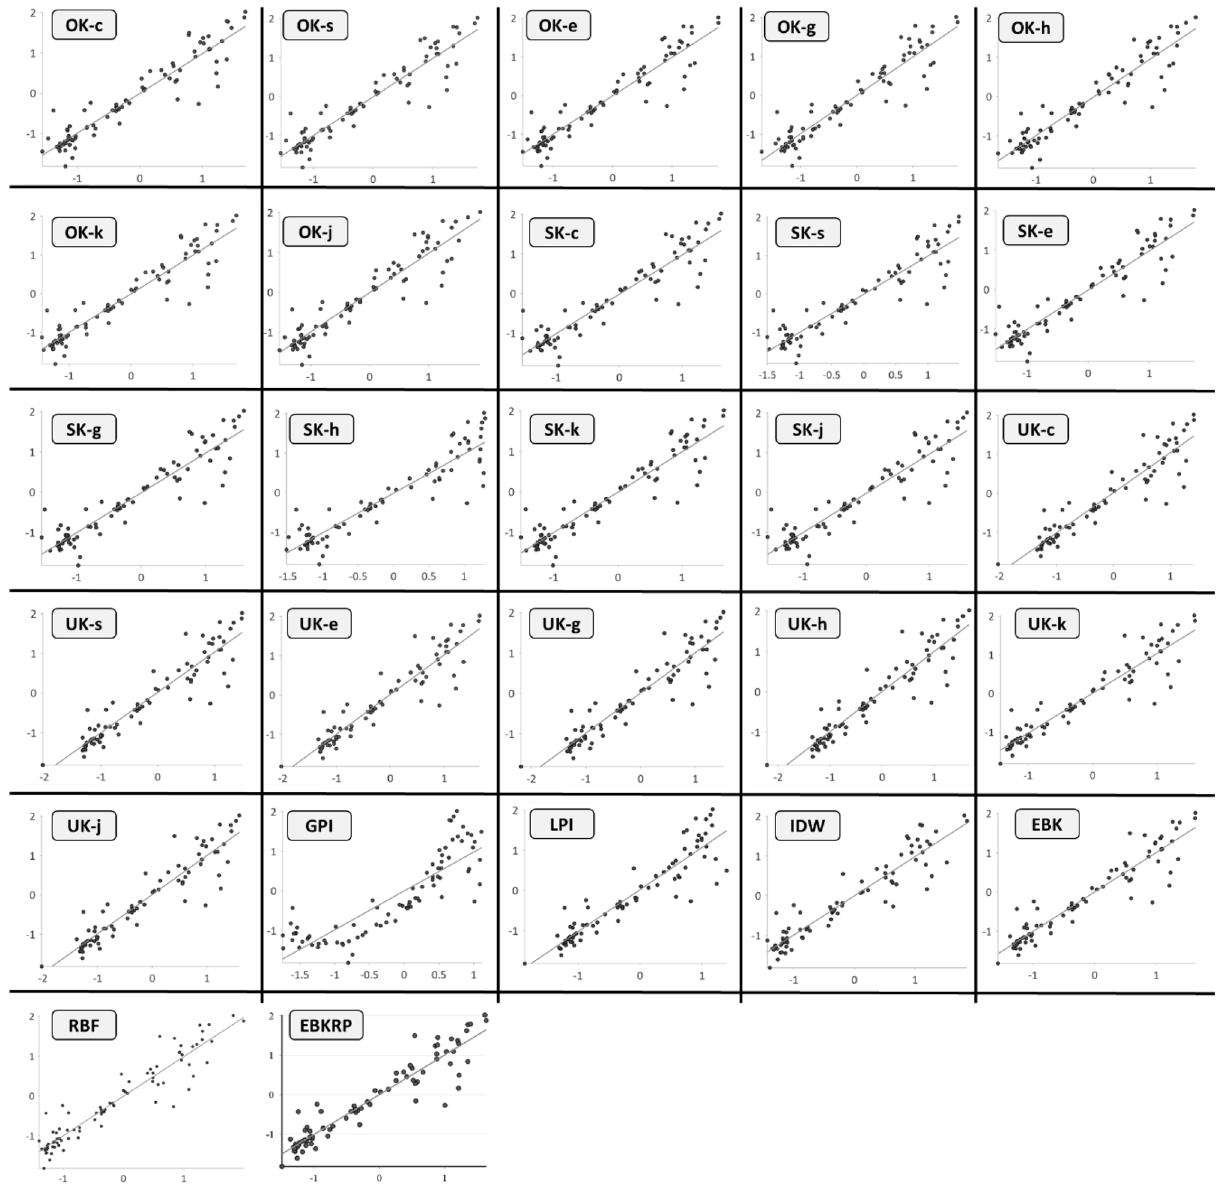
Figure 2. Scatter plots of measured (y-axis) vs. predicted (x-axis) rainfall values from all interpolation methods. The plots are generated in ArcGIS Pro (Version 2.7) from the Environmental Systems Research Institute (ESRI) by a co-author M.S., available at www. esri.